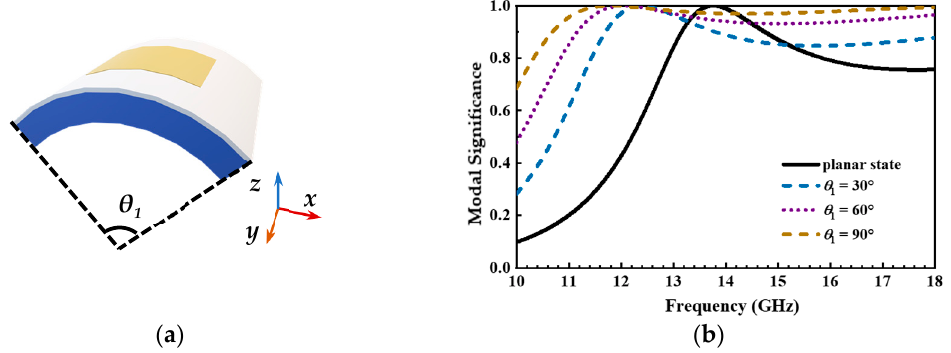
Figure 10. Various bending modal behaviors of the top substrate, radiation patch, and honeycomb equivalent layer, ( a ) bending states, and ( b ) modal significance.